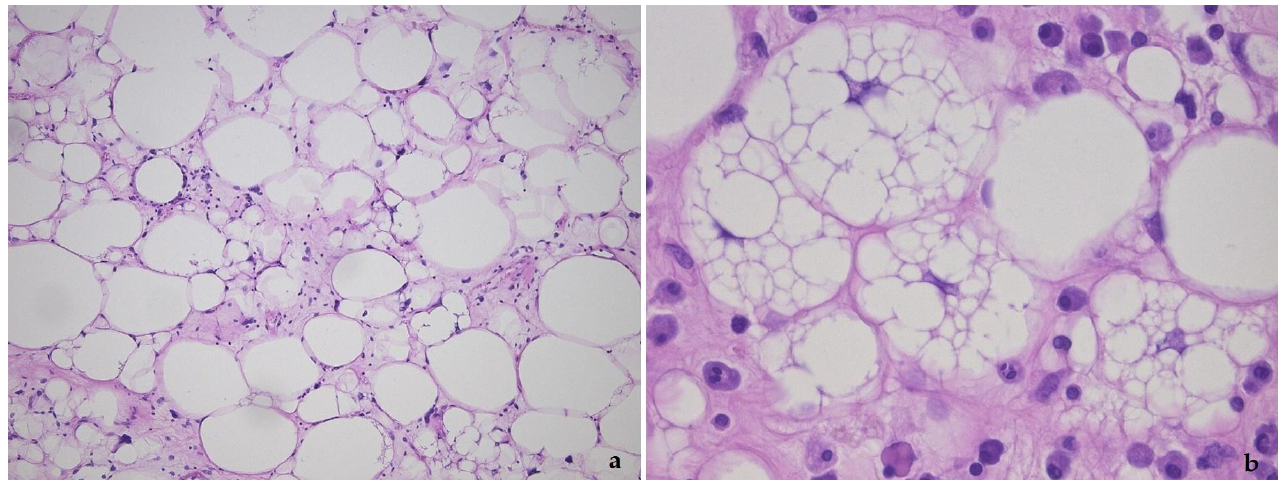
Figure 1. Lipoma-like variant of well-differentiated liposarcoma/atypical lipomatous tumor, showing the variation in adipocyte size, hyperchromatic nuclei and lipoblasts ( a ), detail of lipoblasts with the typical punched-out nucleus in ( b ).